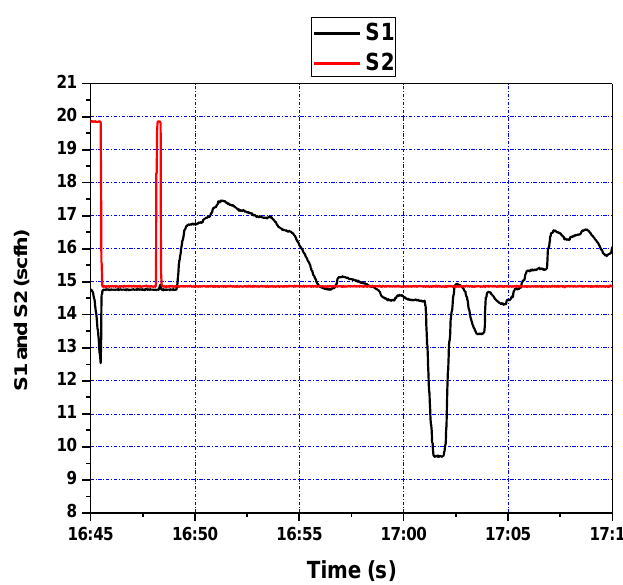
Figure 16. Pressure difference response of riser (DP47) during step setpoint changes.